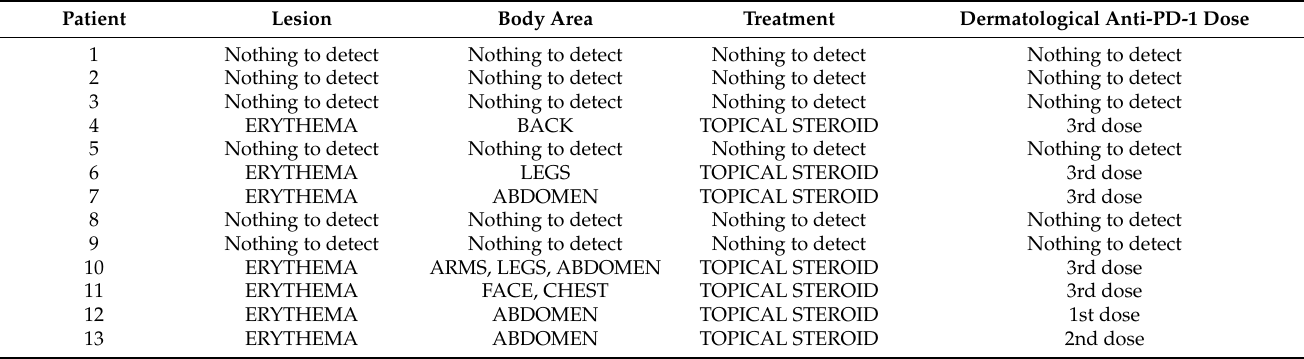
Table 3. Skin immune-related adverse